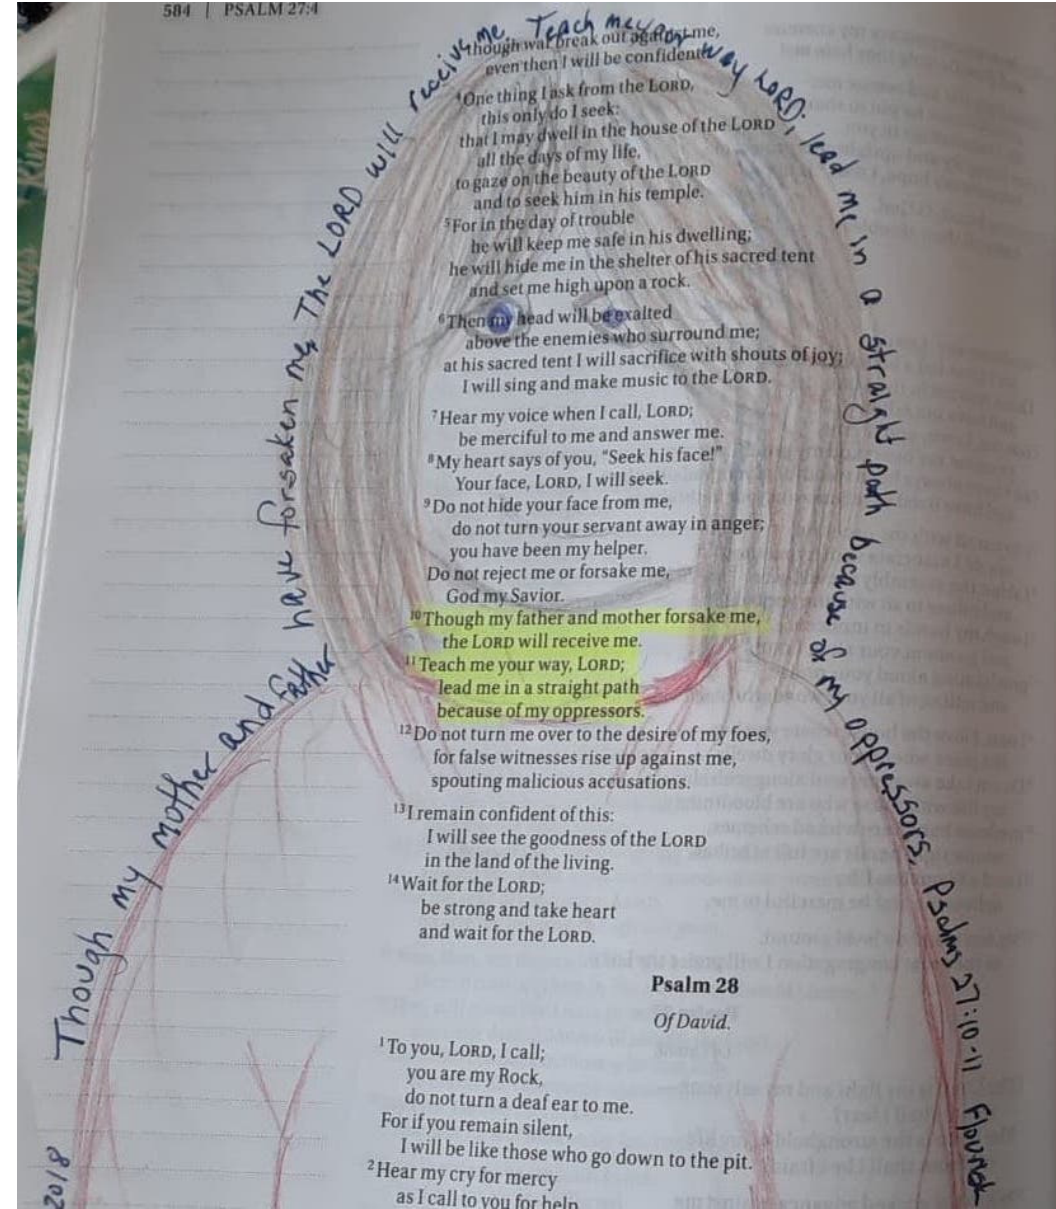
Figure 9. Psalm 27:10-11. With kind permission of the journaler.